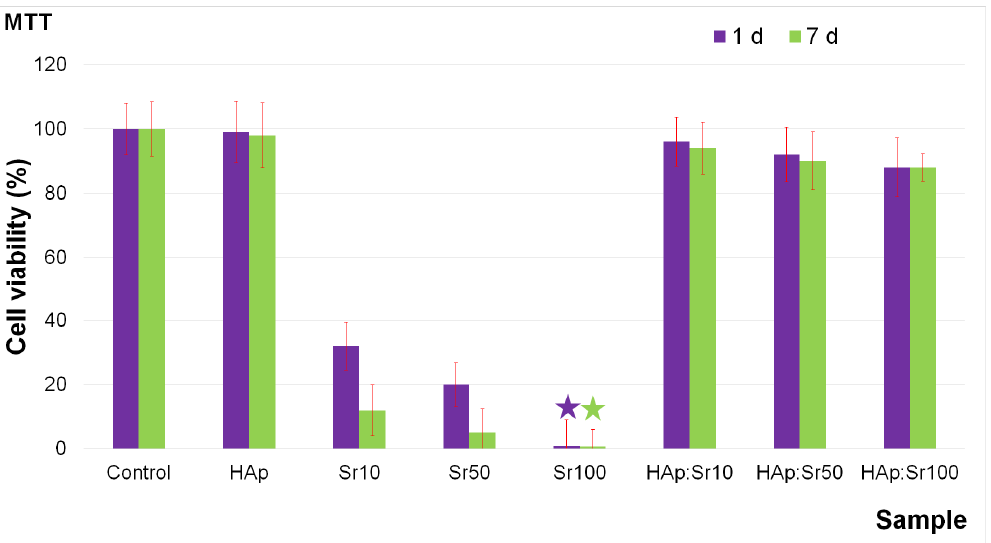
Figure 11. Cell viability of HeLa cells incubated with HAp nanoparticle solution, Sr 2+ -contaminated solutions, and solutions decontaminated using HAp nanoparticles for 1 day and 7 days. HeLa cell culture was used as the control.